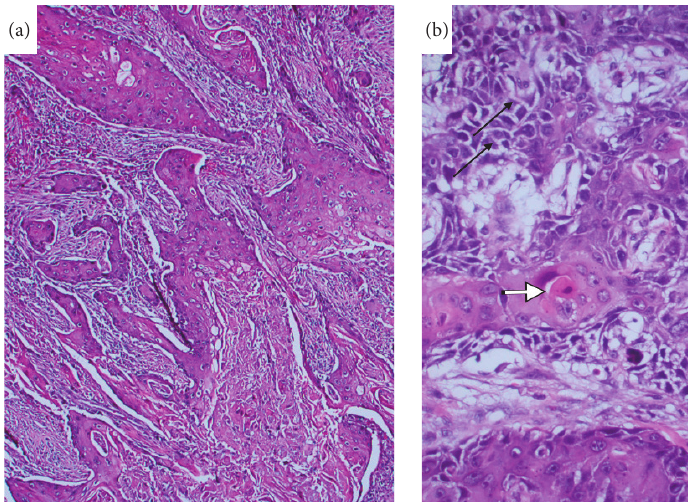
Figure 4: Microscopic examination of gallbladder shows infiltrating carcinoma (a). Tumor is composed of squamous cells with individual cell keratinization (white arrow) and intercellular bridges (black arrows) (b).